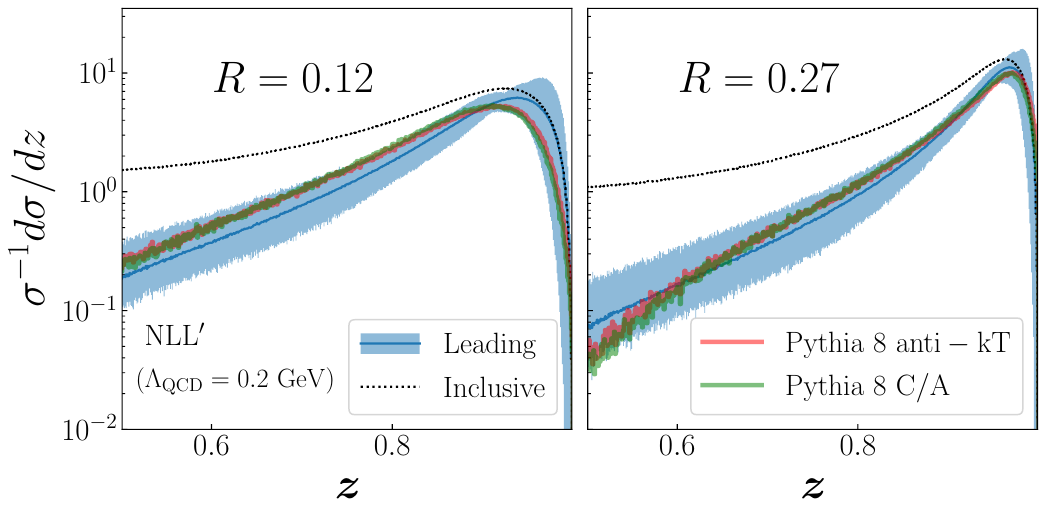
Figure 17 . Event-wide leading jet energy spectrum in e + e − collisions for two values of the jet radius R . We compare to the event-wide inclusive jet spectrum and simulations from Pythia 8 [59].